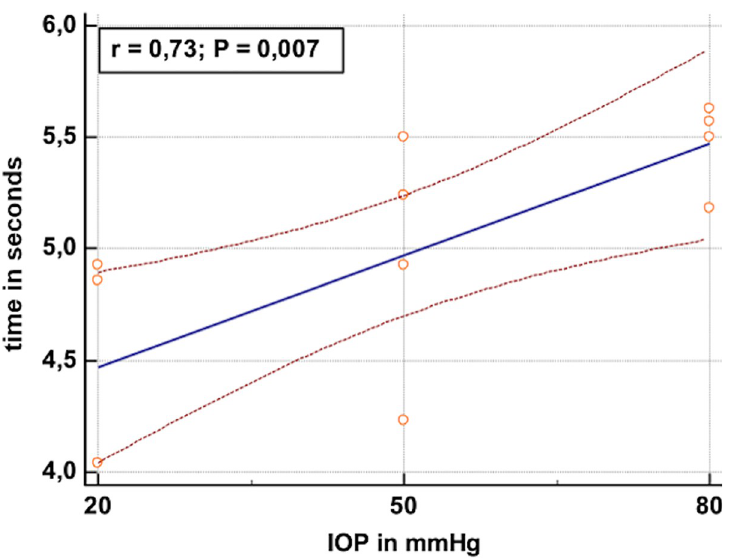
Fig 4. Scatter plot shows the injection time in seconds [s] (Y-axis) for each intraocular pressure [mmHg] (X-axis). Blue line: Regression line. Red lines: 95% confidence